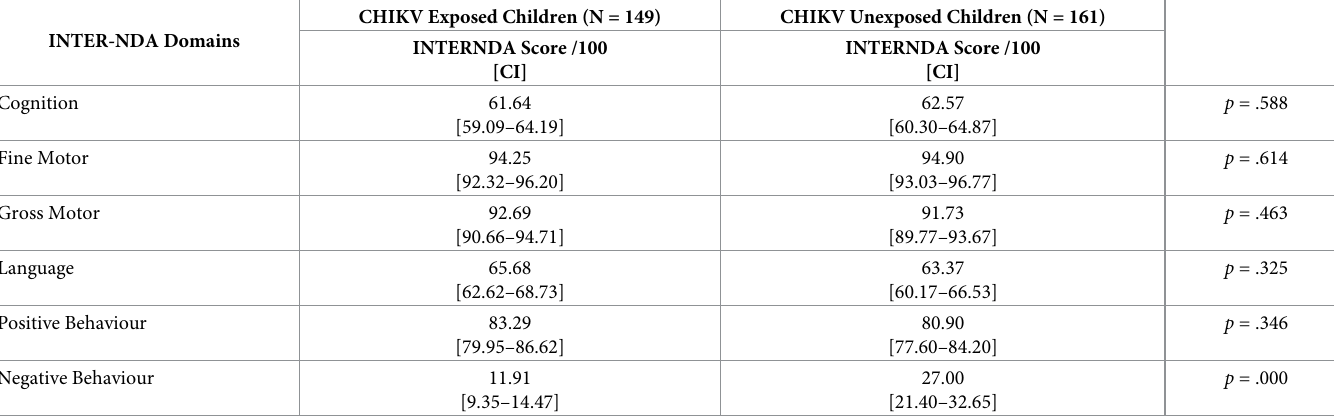
Table 4. Mean differences on standardized INTER-NDA domain scores between CHIKV exposed-uninfected and CHIKV unexposed children at two years of age. INTER-NDA